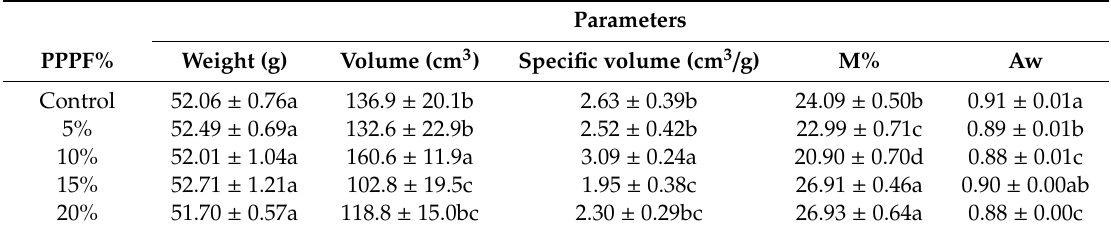
Table 5. Properties of bread samples containing di ff erent percentages of PPPF.